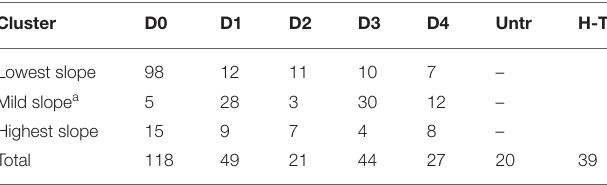
TABLE 3 | Number of studied untreated (Untr), heat-treated (H-T), and pressure-treated (PI-positive) cells in each cluster on days 0–4